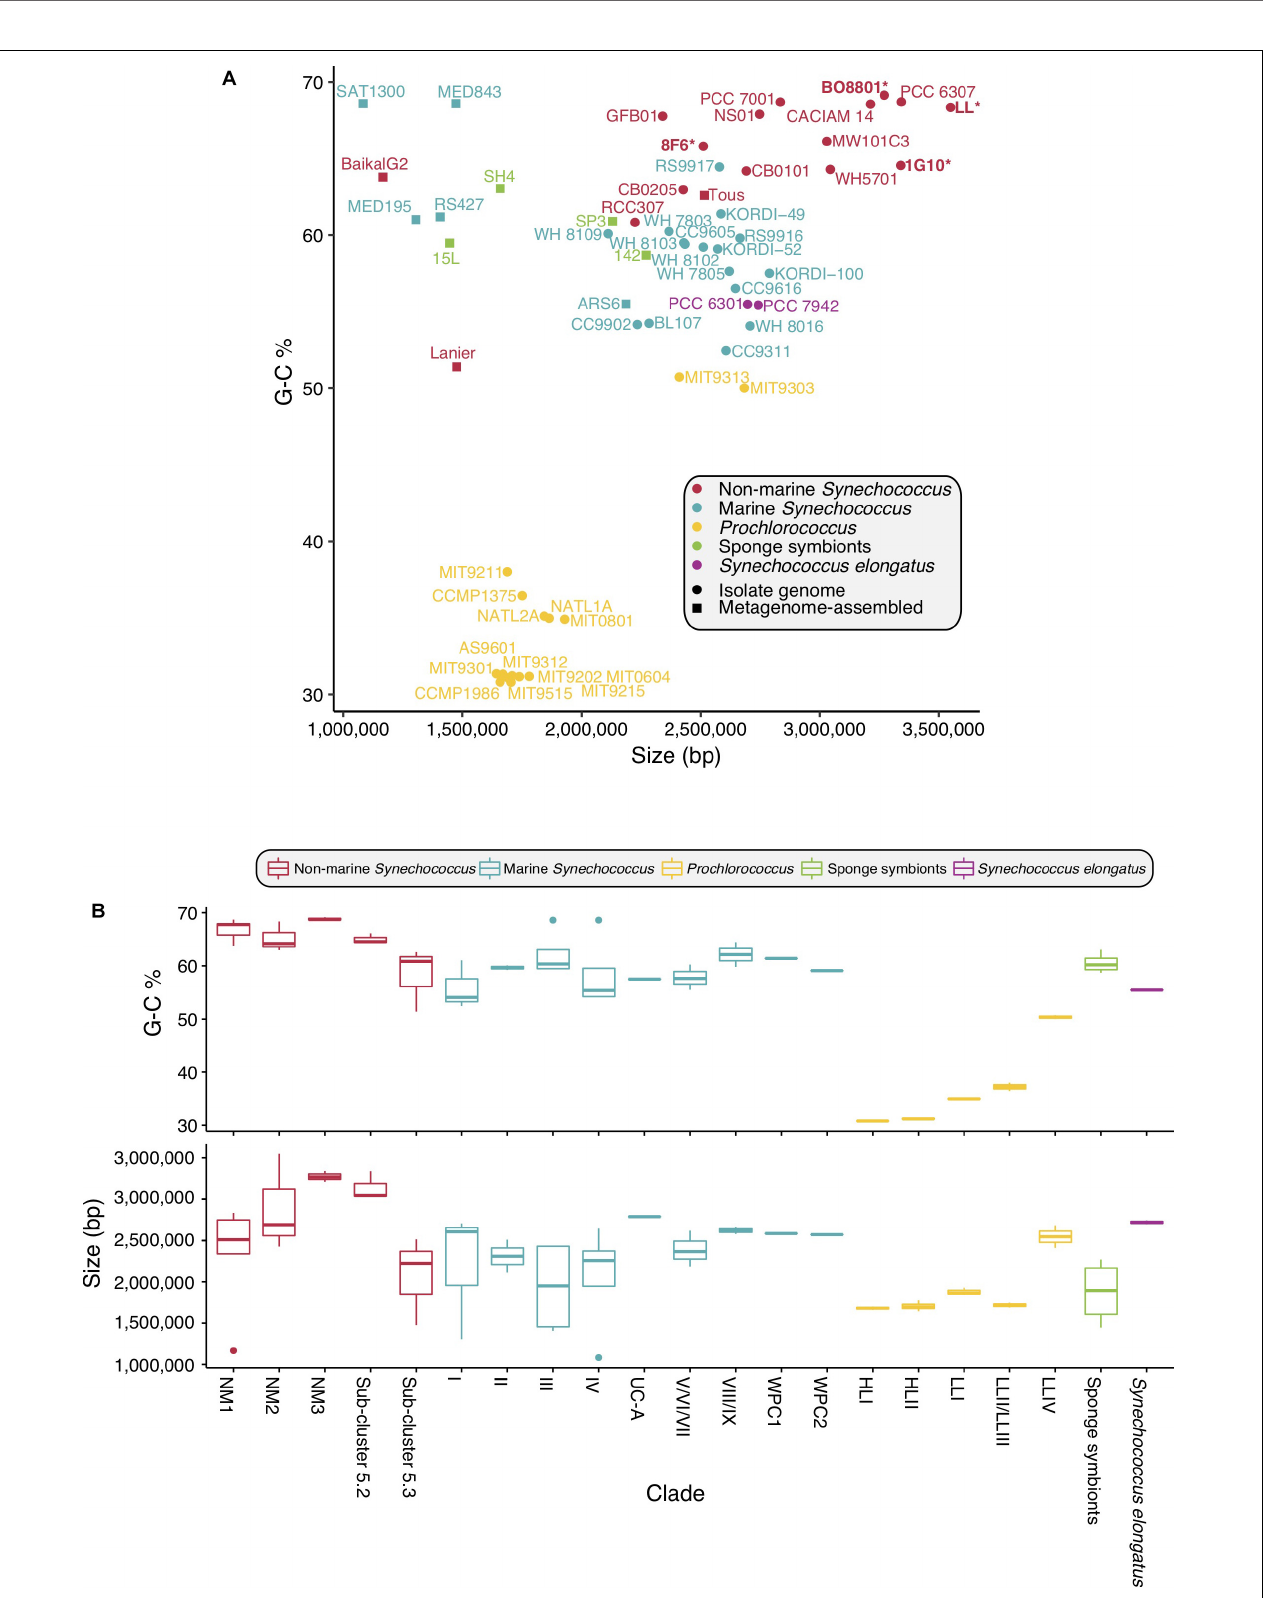
FIGURE 4 | Genome size and GC content of picocyanobacteria. (A) GC content plotted against size. Newly sequenced genomes are in bold marked with ∗ . (B) GC content and genome size within each Sub-cluster.